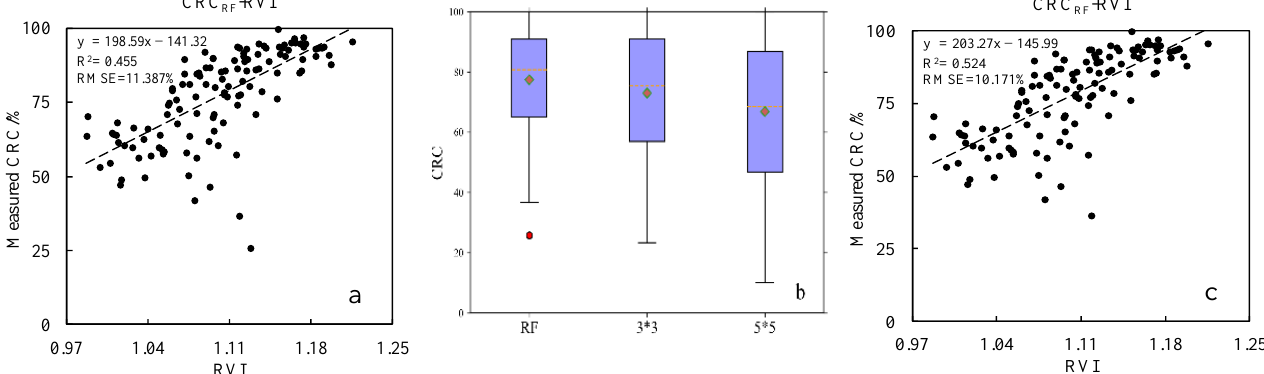
Figure 7. Comparison of GF - 1 experimental sample CRC RF -RVI before and after the removal of outliers (elimination of outliers from the boxplot ( b ), before ( a ), after ( c )).